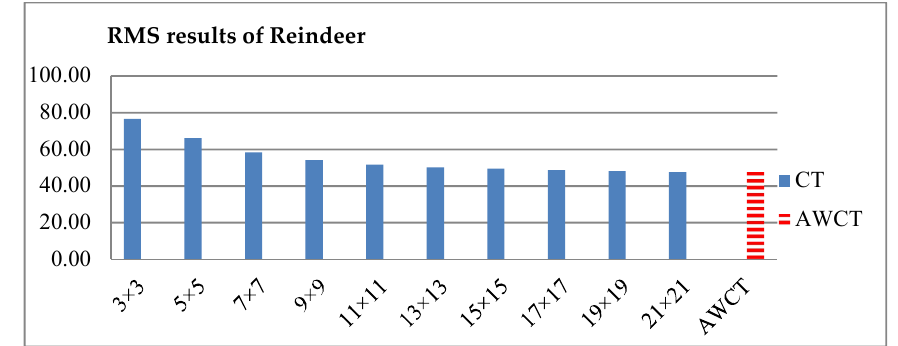
Figure 16. RMS comparison results of Flowerpots between AWCT and CT.